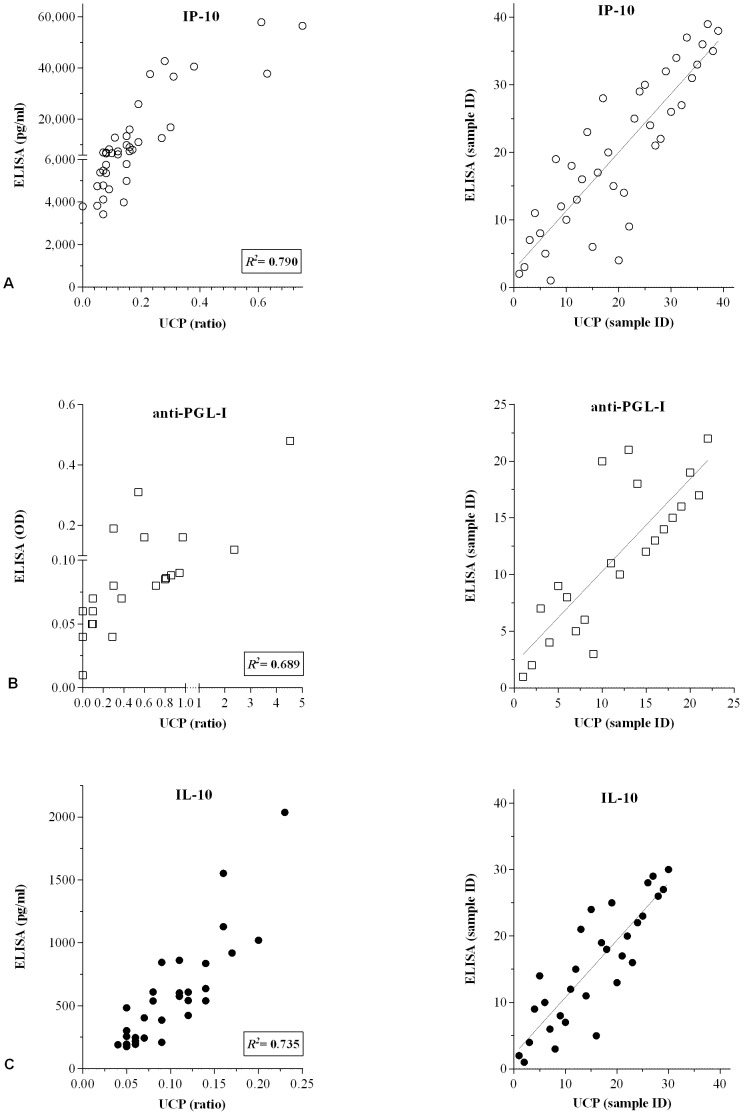
Correlation between ELISAs and UCP-LFAs.Levels of IP-10 (A; n = 40), anti-PGL-I antibodies (B; n = 22) or IL-10 (C; n = 40) in WBA samples were simultaneously determined by ELISAs and UCP-LFAs in Ethiopia using dry-format (A, B) or wet format (C) UCP-LFAs. For cytokine analysis (A and C), samples of Ethiopian leprosy patients (2 BT and 8 BL) that were unstimulated or stimulated with M. leprae WCS, ML2478 or PHA were used. For anti-PGL-I antibodies (B), samples of Ethiopian leprosy patients (2 BT and 8 BL) and healthy endemic controls (n = 12) were used. Left panels: results for ELISA are indicated in pg/ml (A, C) or OD450 (B) or as the ratio of the relative fluorescence units (RFUs) measured at Test and Flow-Control lines (UCP-LFA). R2 equals the square of the Pearson correlation coefficient. Correlation was calculated for samples with ELISA values higher than the cut-off threshold. Right panels: Spearman ranking.